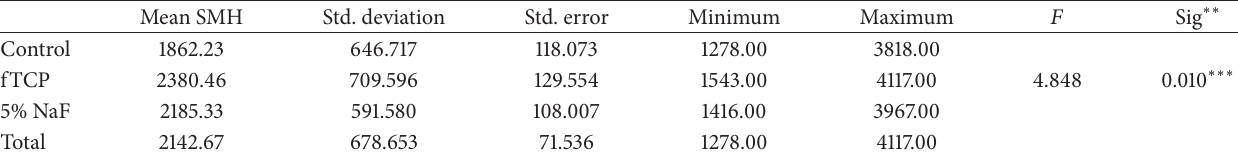
Table 1: Surface microhardness (SMH) values of different groups ∗ .